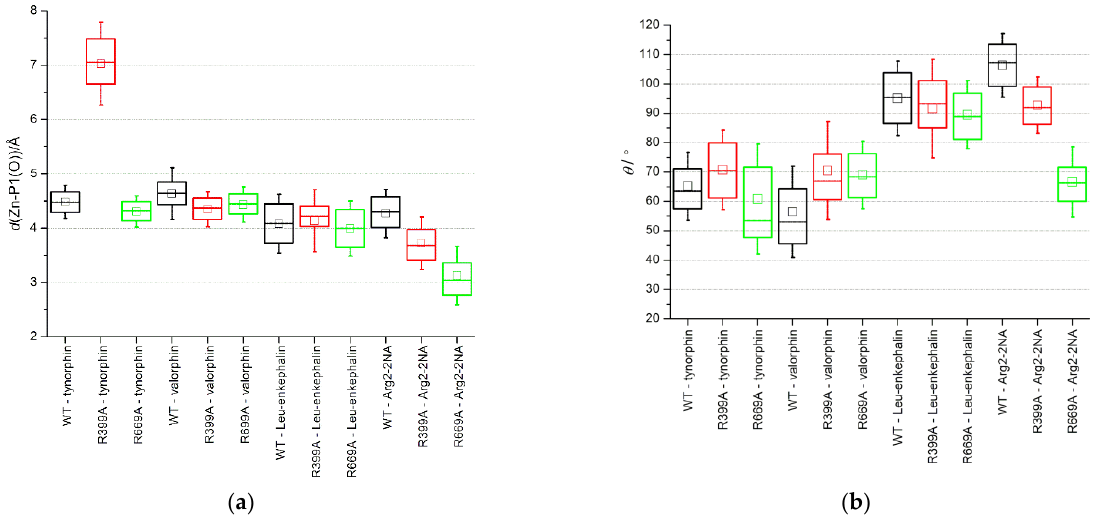
Figure 6. Box plots of ( a ) the distance between the zinc ion and the peptide carbonyl oxygen atom (O) at the P1 position and ( b ) the angle defining the direction of OH − attack calculated between the carbonyl oxygen (O) and carbon (C) of the residue in position P1 and the oxygen atom of the activated water molecule (Ow). The activated water molecule simultaneously coordinated Zn and was hydrogen bonded to E451. The whiskers depict one standard deviation.